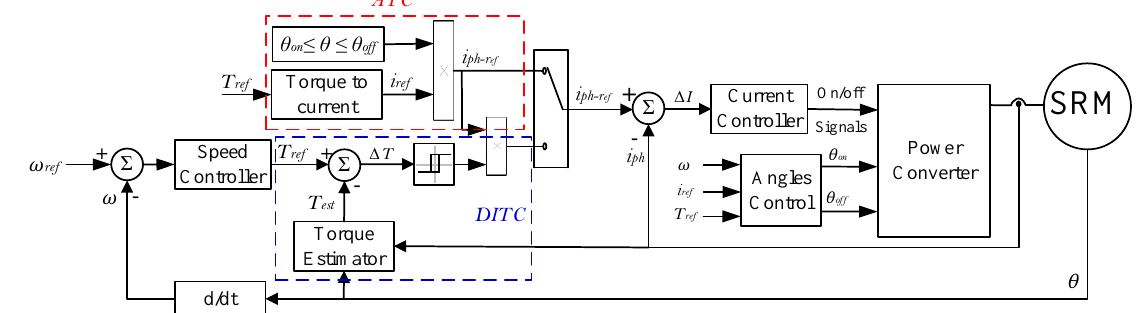
Figure 9. The proposed universal torque control (UTC) of SRM for EVs.